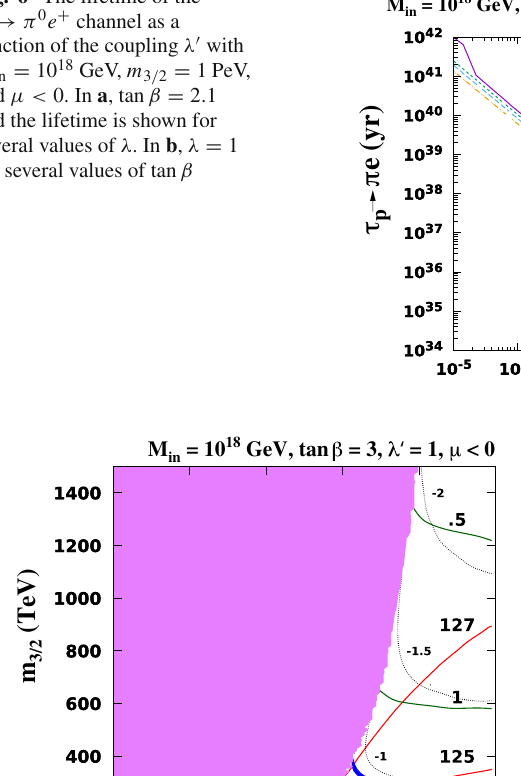
Fig. 6 The lifetime of the p → π 0 e + channel as a function of the coupling λ (cid:7) with M in = 10 18 GeV, m 3 / 2 = 1 PeV, and μ < 0. In a , tan β = 2 . 1 and the lifetime is shown for several values of λ . In b , λ = 1 for several values of tan β